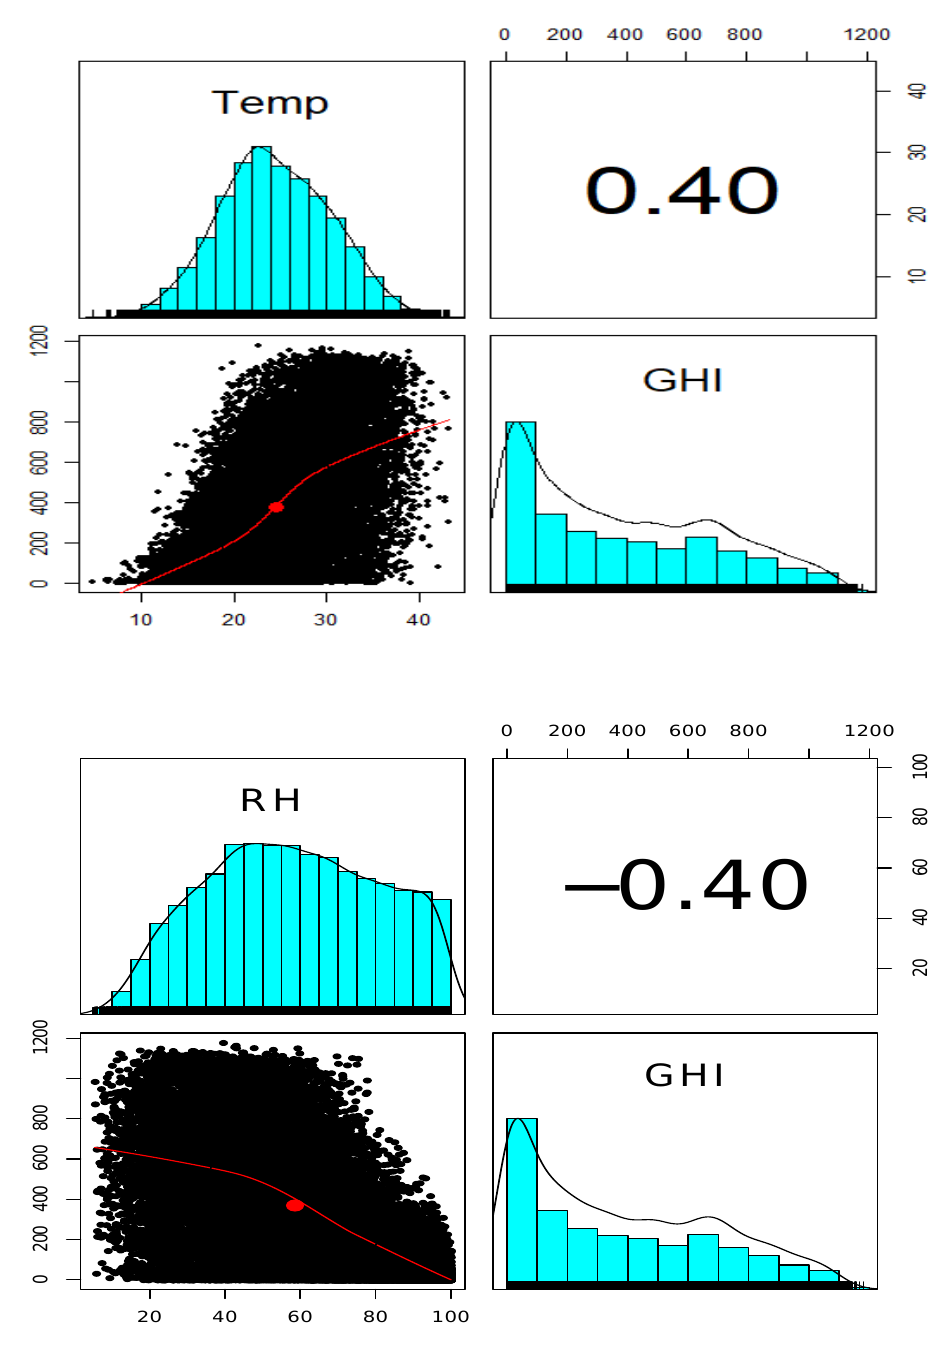
Figure A1. Top panel: Pairs panel GHI against temperature using Kendall method. bottom panel: Pairs panel GHI and relative humidity.